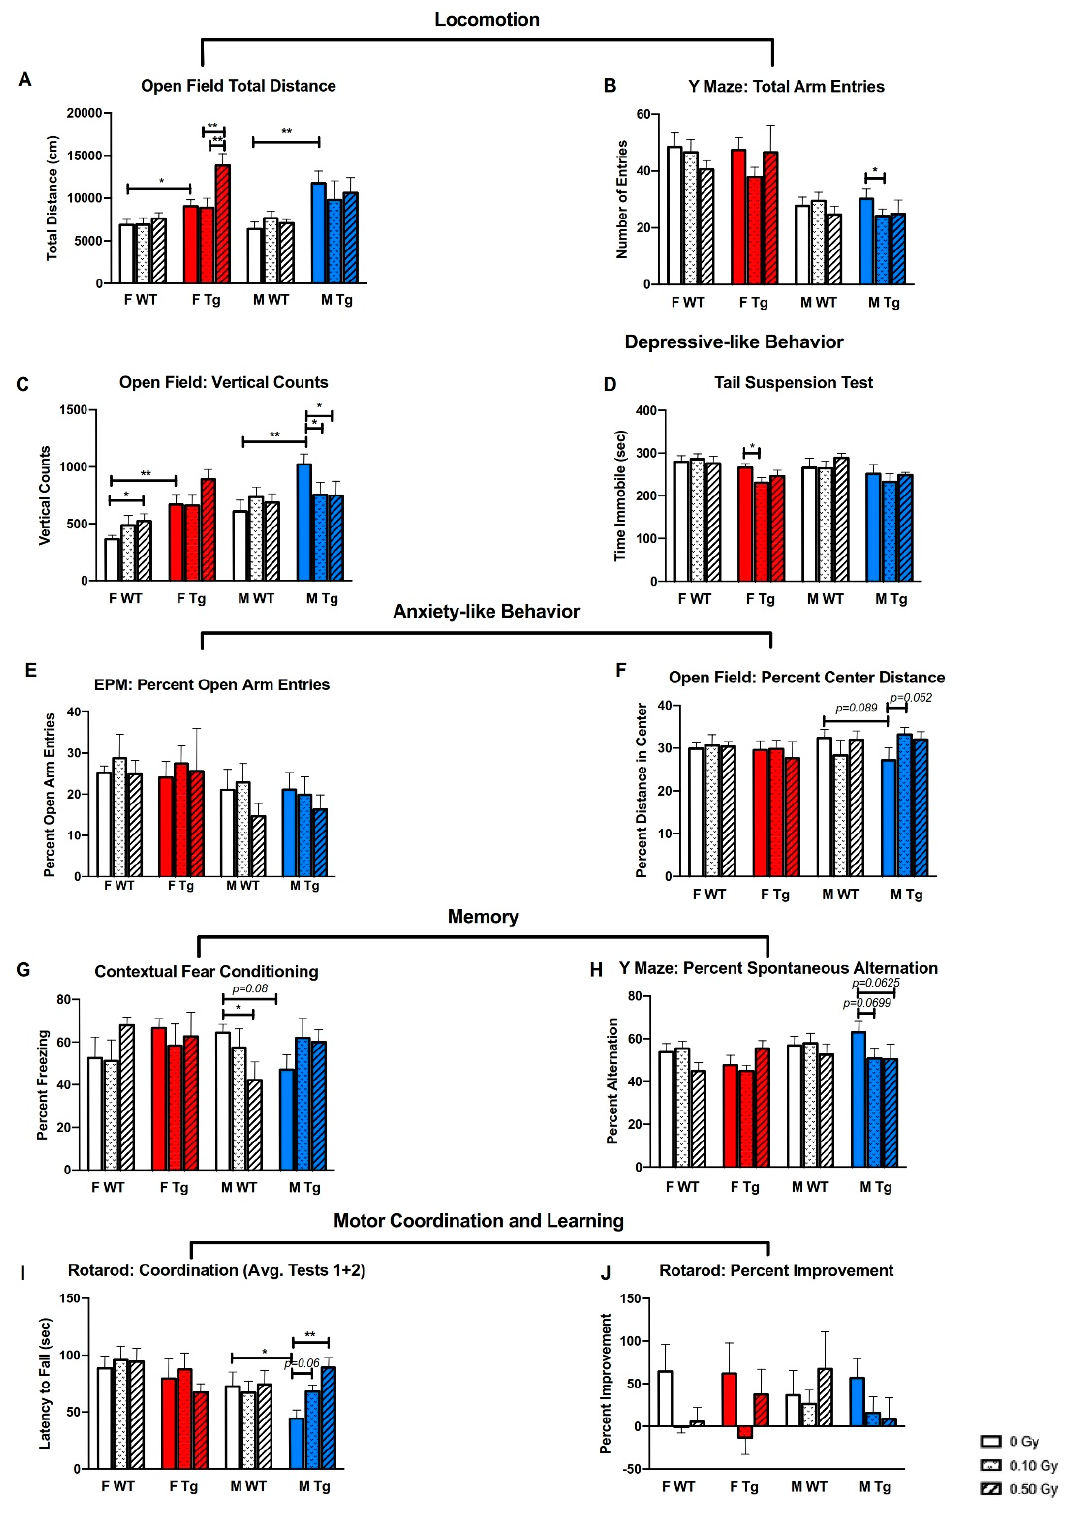
Figure 1. Late behavioral changes in APP/PS1dE9 and WT mice after a single dose of whole-body 56 Fe irradiation were dependent on sex, genotype, and dose. Four-month-old male and female APP/PS1dE9 APP/PS1 (Tg) mice and WT littermates were irradiated with 0, 0.10 or 0.50 Gy of 56 Fe irradiation at BNL and a subset of these mice ( n = 4–9 mice/group) went through behavioral tests starting at seven months post-irradiation. ( A – C ) 56 Fe irradiation had sex- and genotype- specific effects on tests of locomotor activity, including total distance in the open field ( A ), total arm entries in the Y maze ( B ), and total vertical counts in the open field ( C ). ( D – F ) 56 Fe irradiation had sex- and genotype-specific effects on tests of depressive-like behavior including less time immobile on the tail suspension test in female APP/PS1 mice in the 0.10 Gy